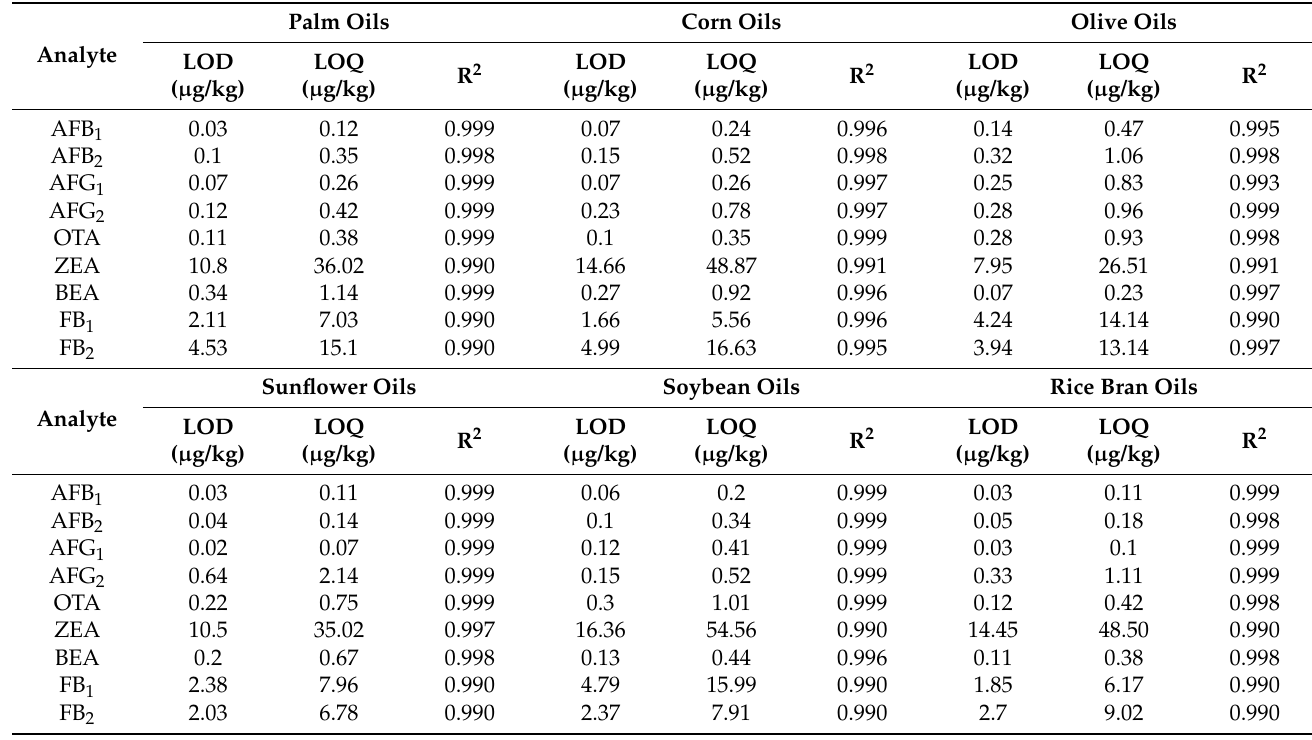
Table 2. Linearity ranges (R 2 ), limit of detection (LOD), and limit of quantification (LOQ) of optimized LC–MS/MS method for simultaneous determination of nine mycotoxins.